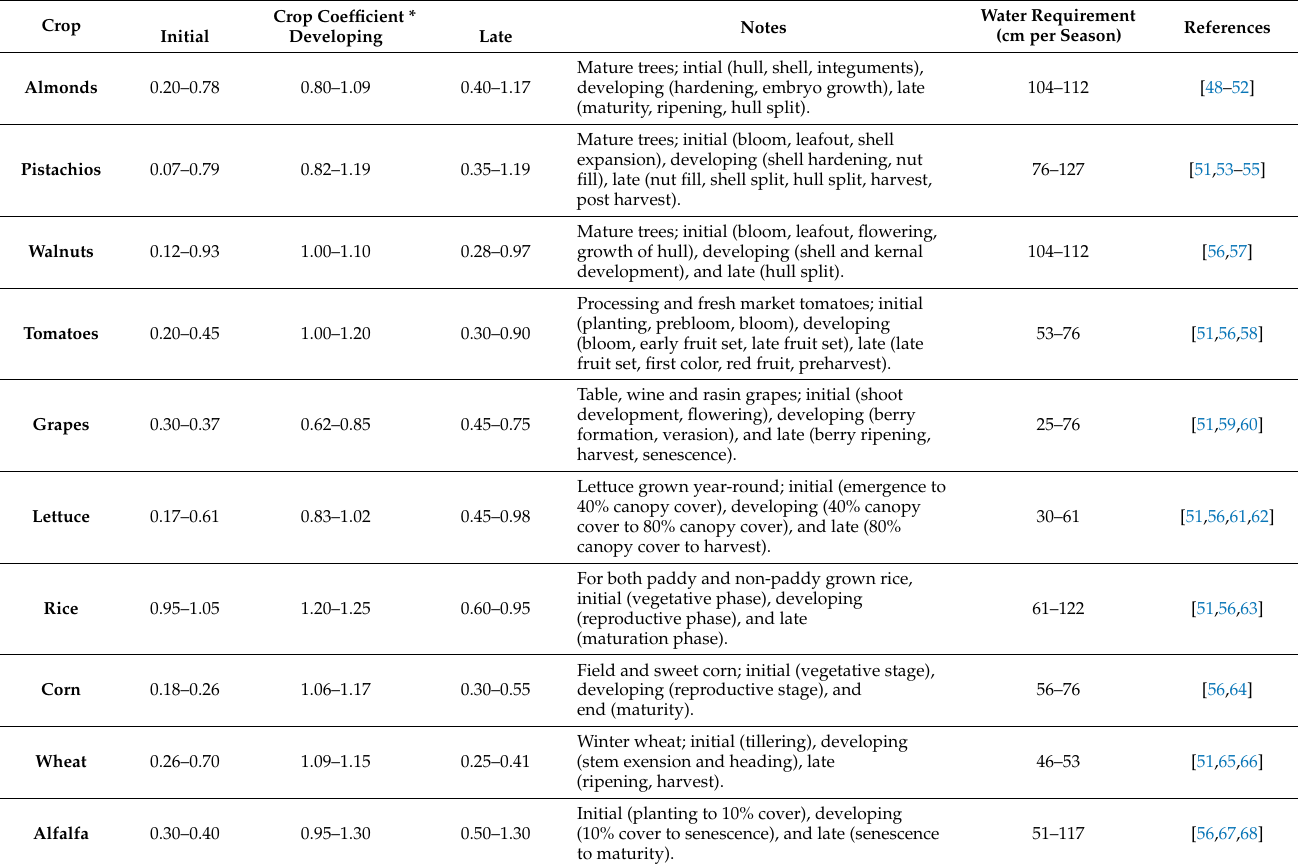
Table 1. Crop coefficient and seasonal water requirement ranges of major crops of California. Crop coefficient periods have been approximated for each crop, see notes column for more details.